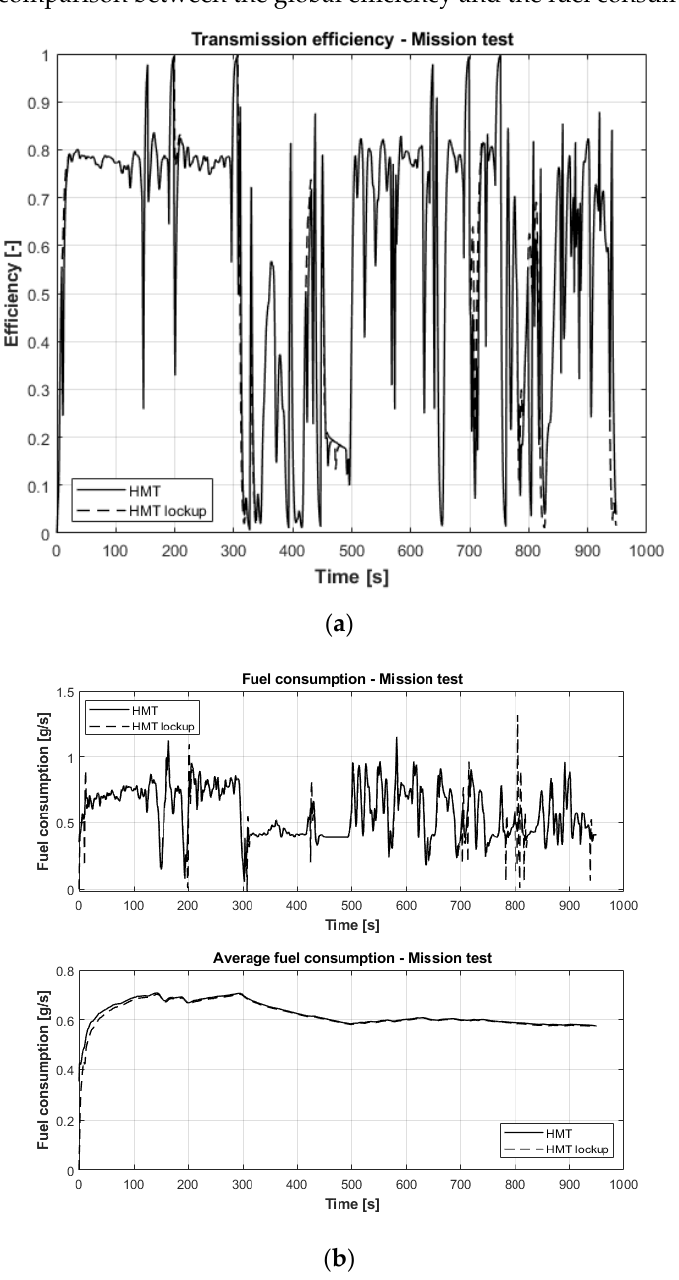
Figure 18. Comparison between input-coupled HMT and input-coupled HMT with lockup clutch on a real driving cycle. ( a ) Global efficiency. ( b ) Fuel consumption.